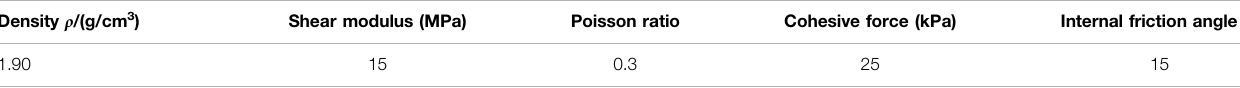
TABLE 3 | Blast-hole Stemming parameters.